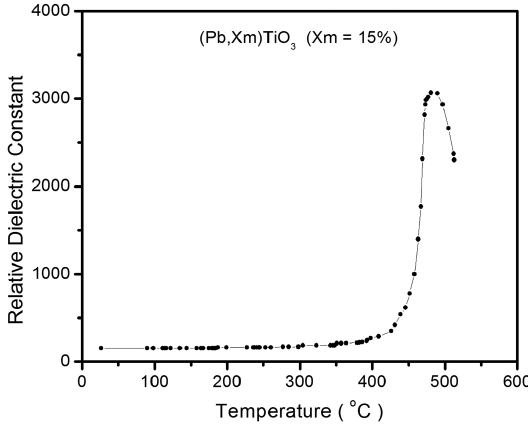
Figure 6. Relative dielectric permittivity as a function of temperature for PXT15 sample sintered at 1150 °C.